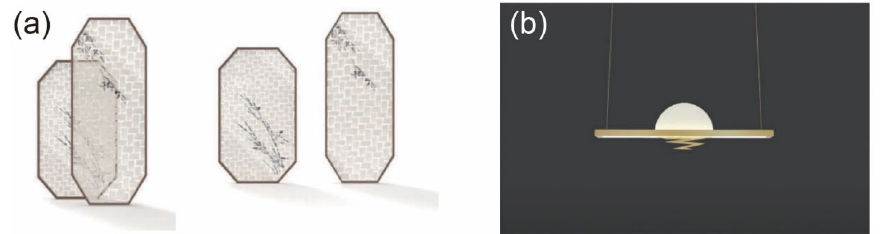
Figure 7. Decorative applications of TB: ( a ) woven composite screens; ( b ) sunset chandelier [76]. (( a , b ) Reproduced with permission from ref. 76. Copyright 2021 Editorial Department of Journal of furniture. ).